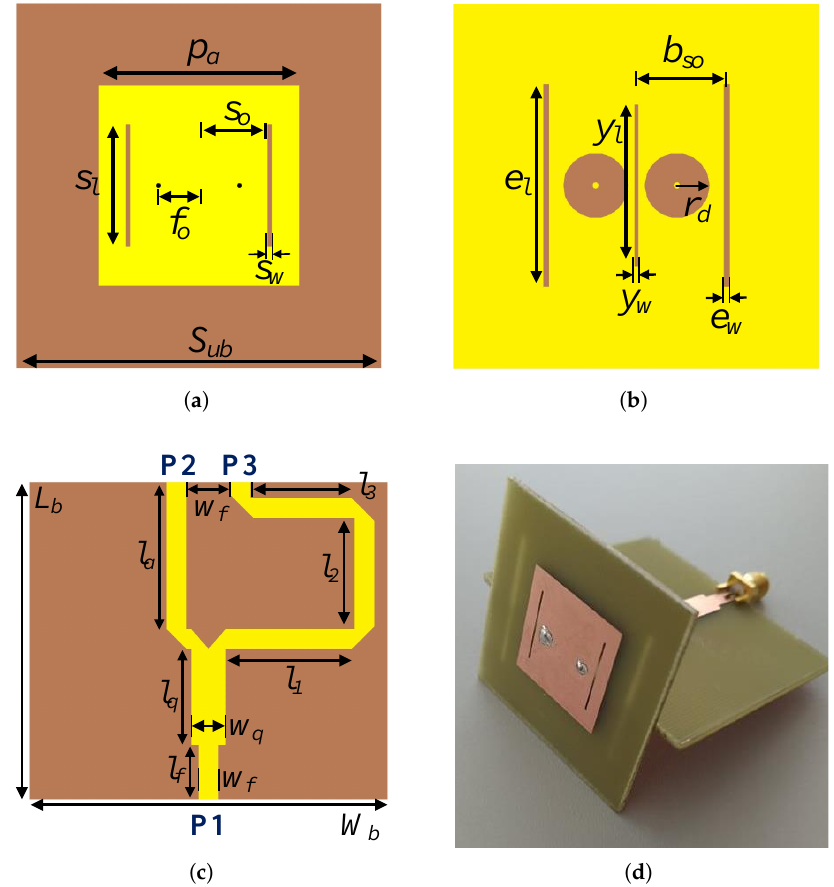
Figure 9. Sensor node antenna: ( a , b ) top and bottom layout views, respectively; ( c ) balun top view, and ( d ) final antenna prototype (overall dimensions: 55 × 55 × 50 mm 3